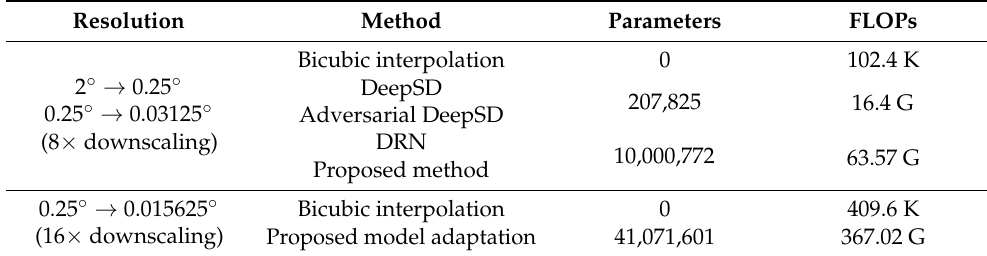
Table 6. The parameters and FLOPs of the (primal) model during model inference.